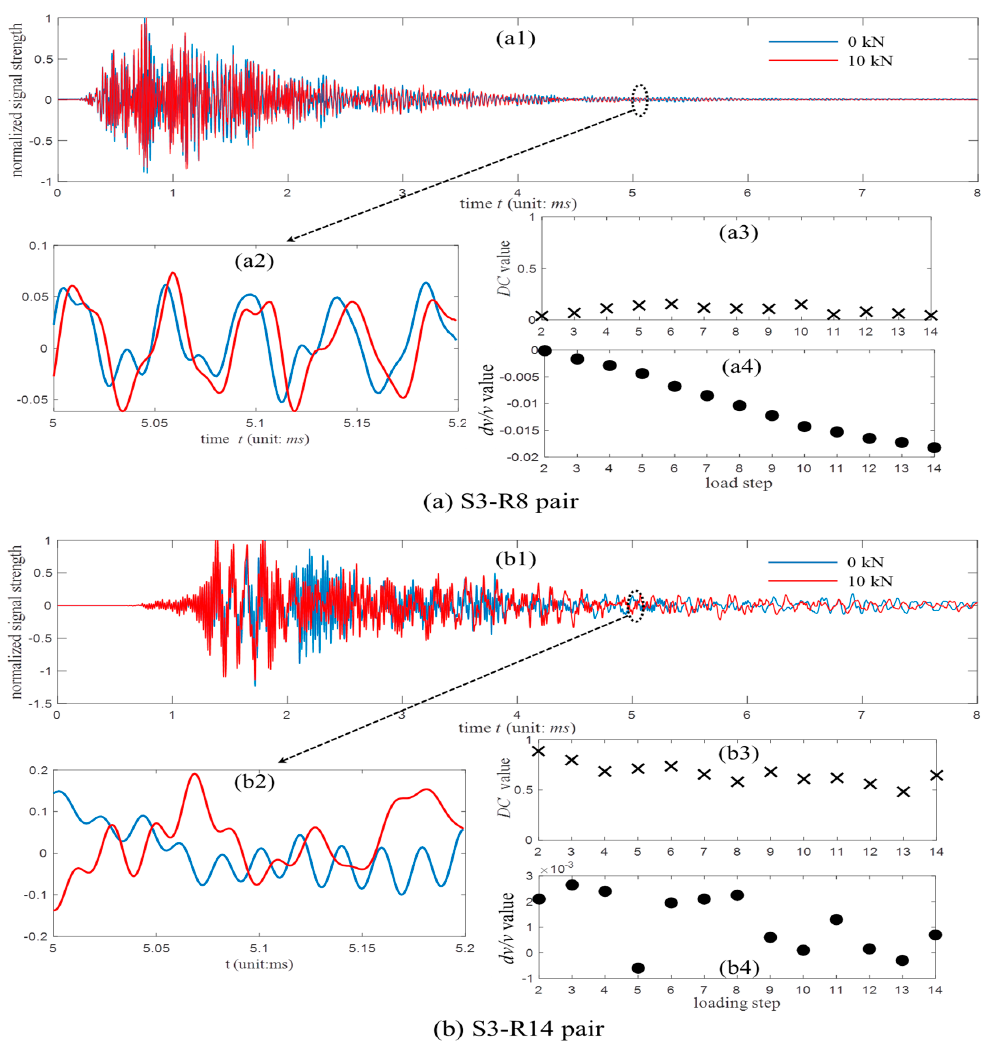
Figure 4. The waveforms as well as the decorrelation ( DC ) and dv / v values collected with the ( a ) S3-R8 and ( b ) S3-R14 pairs under varied loads.